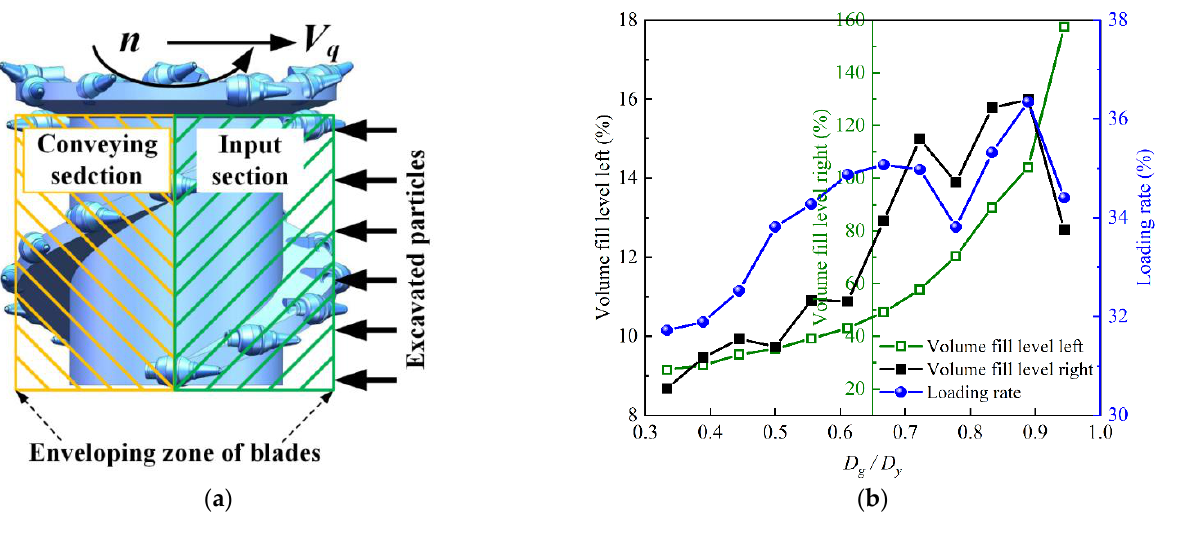
Figure 18. ( a ) Schematic diagram of input and conveying half under pushing conditions; ( b ) the relationship between filling rate and loading rate ( D y = 900 mm).